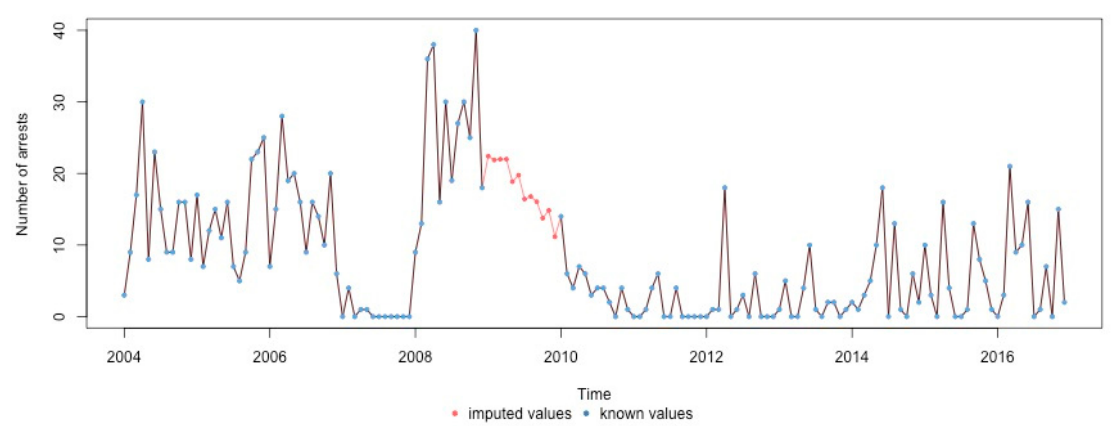
Figure A12. Methamphetamine-related organized Czech nationals crime arrests 2004–2016 in the Czech Republic—imputed missing values.